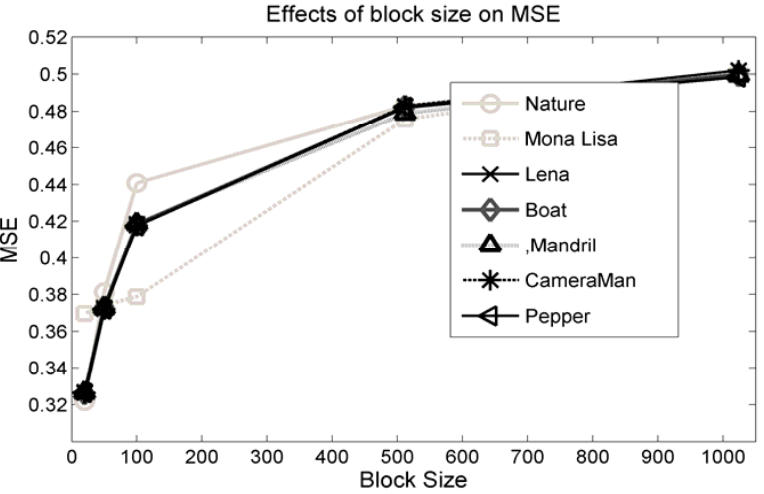
Figure 9. Effect of message block size on MSE (mean square error).